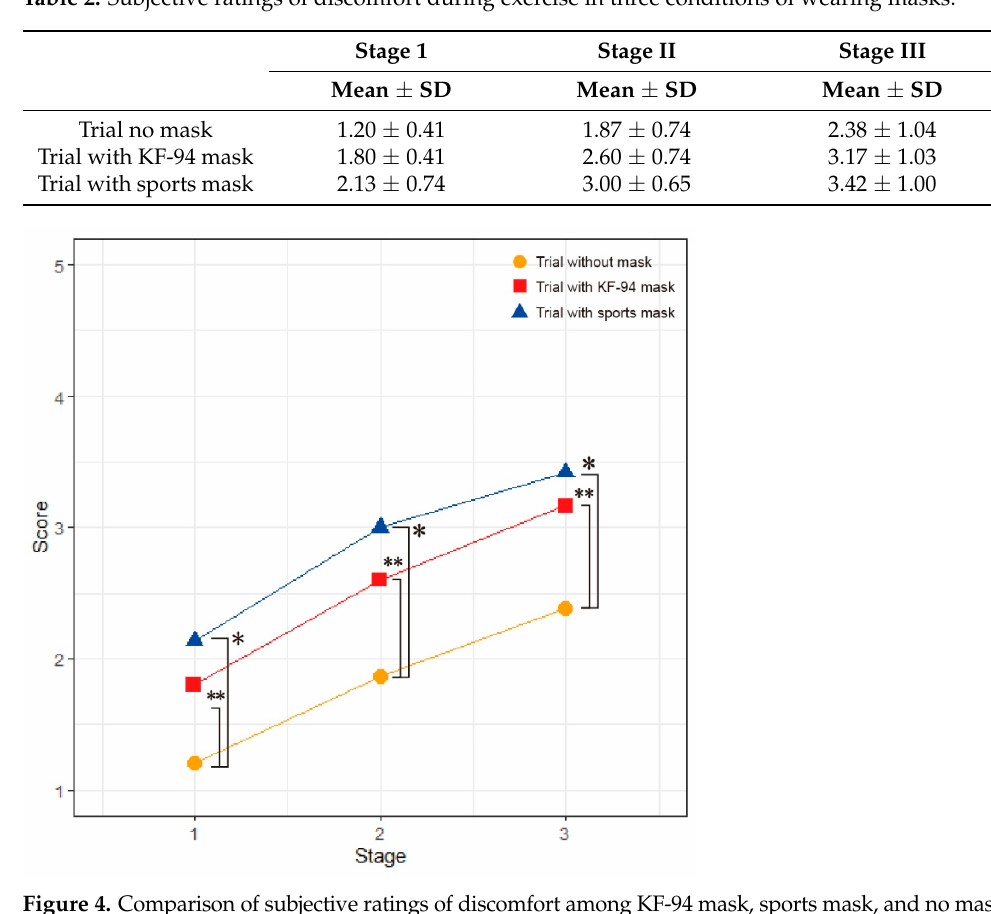
Table 2. Subjective ratings of discomfort during exercise in three conditions of wearing masks.